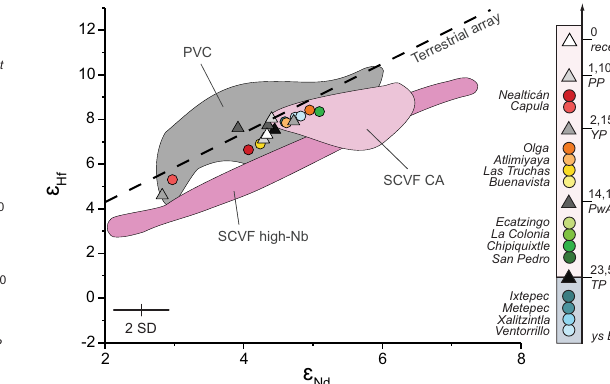
Figure 5: Sr–Nd isotope systematics for Ventorrillo and Popocatépetl lavas and pumices. For comparison, literature data for present-day activity [Schaaf et al.